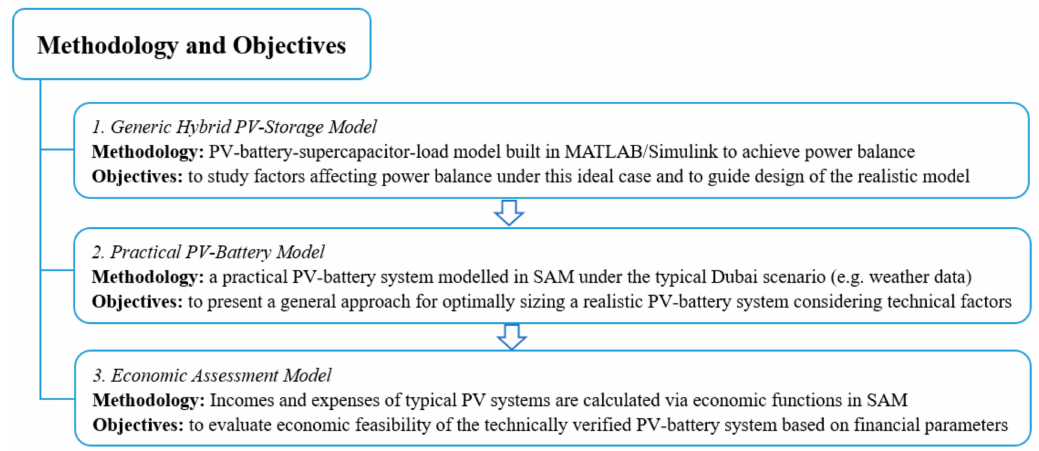
Figure 1. The logic sequence of developing three test models.